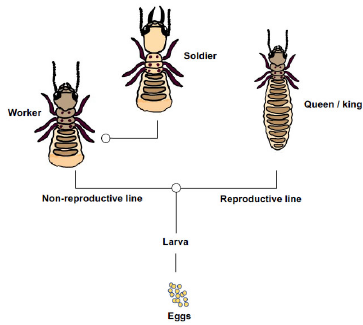
Figure 1. A simplified representation of caste developmental pathway in Reticulitermes flavipes [18,27]. Larvae differentiate into non ‐ reproductive (worker and soldier) or reproductive (nymphs, primary queens and kings) castes. Workers can further differentiate into soldiers. These two points of caste differentiation or ‘switches’ sensu [28] are shown by open circles. Similar to the process of caste differentiation, this social transition from colonial to unicolonial lifestyle may be mediated by environmental cues, but genetic bottlenecks and other sweeping changes to genetic diversity upon invasion may also play a role, especially if they dampen nestmate recognition cues that in turn lowers aggression [29]. Here, we exploit a series of cDNA libraries previously derived from whole ‐ body tissue of three dif ‐ ferent castes as well as from behaviourally distinct colonial and unicolonial populations of the Eastern subterranean termite Reticulitermes flavipes . From caste ‐ and population ‐ specific libraries initially assembled by Wu et al. [30], we test for differences in expressed gene diversity between one reproductively selfish (wing ‐ padded nymphs) and two repro ‐ ductively altruistic (worker, soldier) castes. If caste differences are partly explained by genotype, then we expect caste ‐ specific libraries to differ in the number, type or pattern of single nucleotide variants (SNVs). Likewise, if invasive transitions to unicoloniality in R. flavipes are associated with genetic bottlenecks or other systemic changes to nucleotide diversity, then we expect termites collected from invasive populations to harbour fewer SNVs or to otherwise show unique mutational profiles compared to their native counter ‐ parts. We test these two qualitative predictions by comparing the relative number and type of nucleotide substitutions against a consensus reference assembly. 2. Methods 2.1. Acquiring the RNA ‐ Seq Data Set The analyzed dataset consisted of nine RNA ‐ Seq libraries, which were generated from three castes (nymph, soldier, worker). The samples include representatives of both sexes and were collected from each of three separate colonies across three geographic pop ‐ ulations: one invasive (Toronto, ON, Canada) and two that are within the native range (near Raleigh, NC; near Boston, MA, USA). The details of sample collection, processing and sequencing are described in Wu et al. [30] and in Behl et al. [31]. For the purposes of this study, we accessed the National Center for Biotechnology Information Sequence Read Archive (NCBI ‐ SRA) to download each of the nine termite transcriptome libraries (Table 1). Next, we transferred them onto the bioinformatics platform GALAXY [32] for analysis. Each NCBI ‐ SRA file consisted of paired sets of forward and reverse Illumina HiSeq 2000 sequence reads that correspond to a whole transcriptome of the cDNA template. Along ‐ side each of these ~30 Gb FASTQ files, we used FILEZILLA to transfer the corresponding